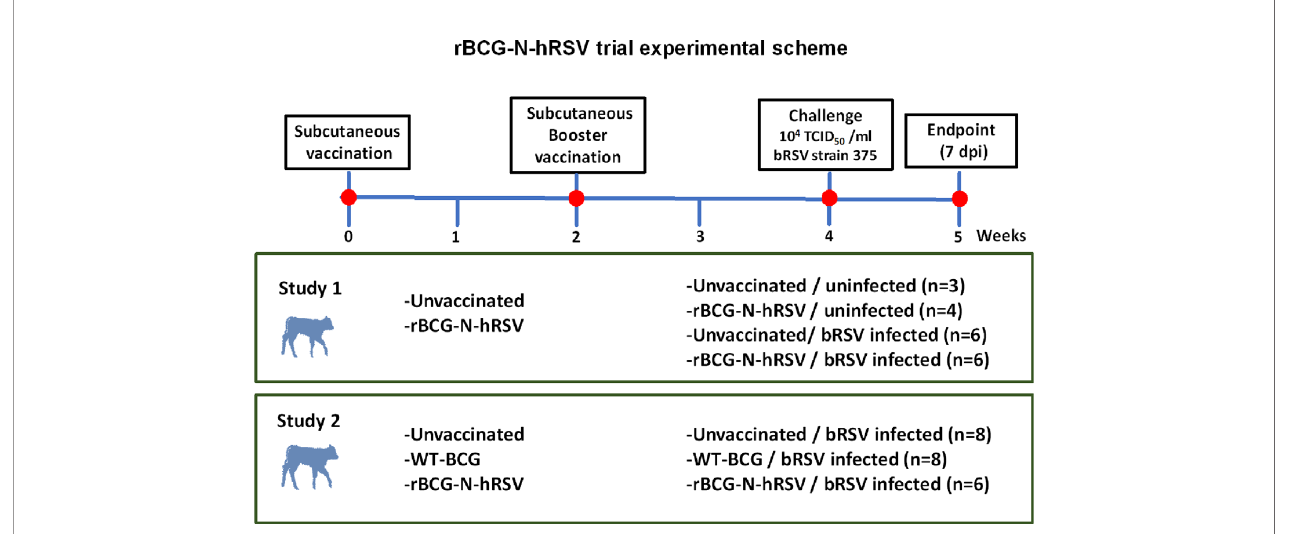
FIGURE 1 | Diagram for the experimental design for studies 1 and 2. Newborn Holstein calves were vaccinated subcutaneously with GMP rBCG-N-hRSV (Studies 1 and 2) or WT BCG (Study 2) and boosted 14 days after prime immunization. Control calves were left unimmunized. After each immunization, animals were monitored for systemic alterations or local reactions to vaccination. Throughout the study, blood was collected weekly from the jugular vein. Fourteen days after the booster, calves were infected with bRSV strain 375 via aerosol inoculation. For Study 1, groups were: unimmunized, uninfected (n=3); rBCG-N-hRSV, uninfected (n=4); unvaccinated, bRSV infected (n=6); and rBCG-N-hRSV vaccinated, bRSV infected (n=6). For Study 2, groups were: Unvaccinated (n=8), WT-BCG vaccinated (n=8), and rBCG-N-hRSV vaccinated (n=6), being all animals bRSV-infected Animals were monitored and sampled daily after challenge to obtain blood and nasal fl uid samples. All animals were euthanized 7 dpi for pathological evaluation and